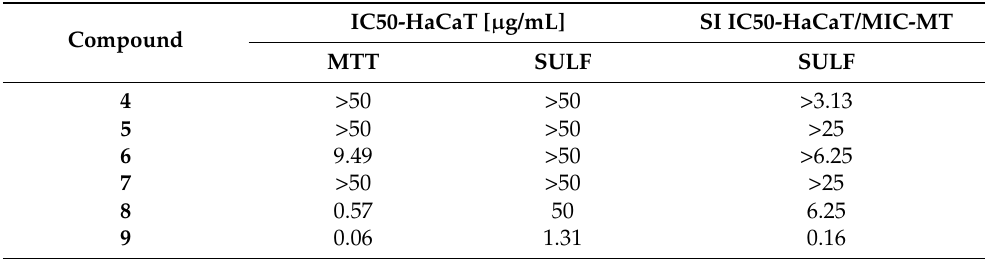
Table 3. Cytotoxic activity of compounds 4 – 9